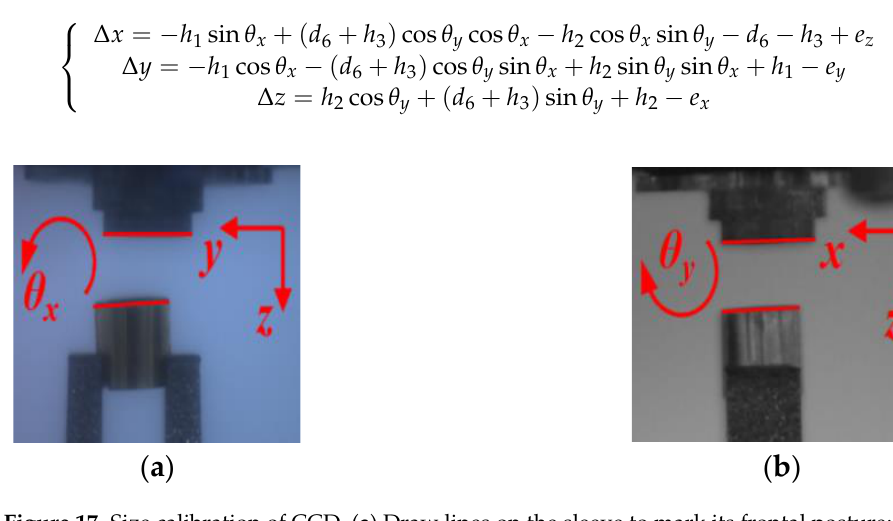
( b ) Figure 18. Parts ’ pose calibration of CCD. ( a ) Front view of sleeve after posture adjustment; ( b ) Left side view of sleeve after posture adjustment.